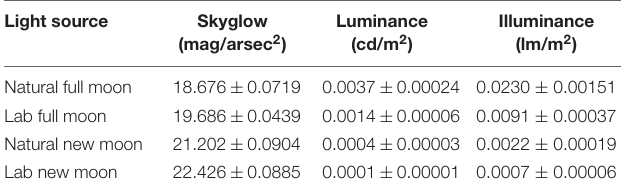
TABLE 1 | Measure of skyglow (mag/arcsec 2 ), luminance (candela [cd/m 2 ]), and illuminance (lux [lm/m 2 ]).